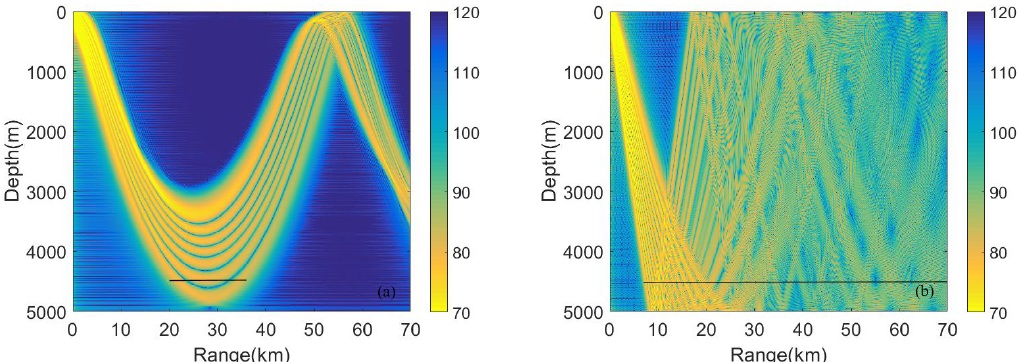
( b ) Figure 4. Transmission loss. ( a ) Refracted and surface reflected (RSR) modes only, phase speeds are less